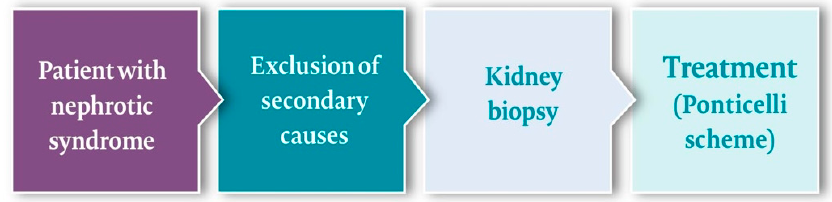
Figure 2. Traditional approach to a patient with MN-related proteinuria.